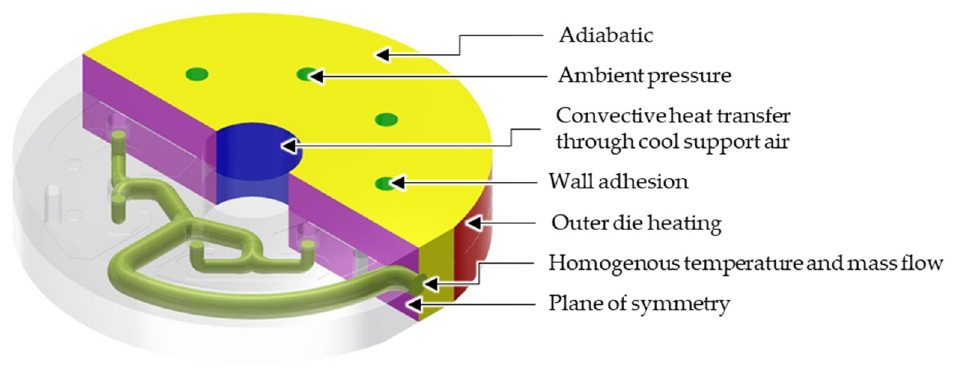
Figure 4. Start and boundary